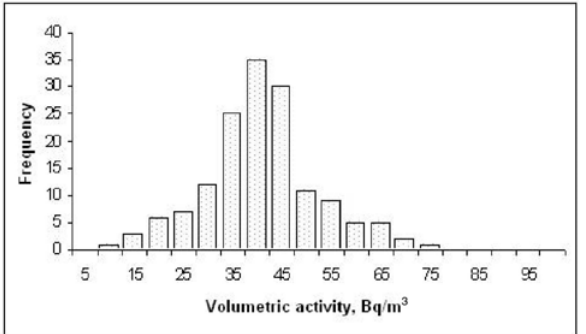
Fig 8. Frequency of indoor radon progeny volumetric ac- tivity in